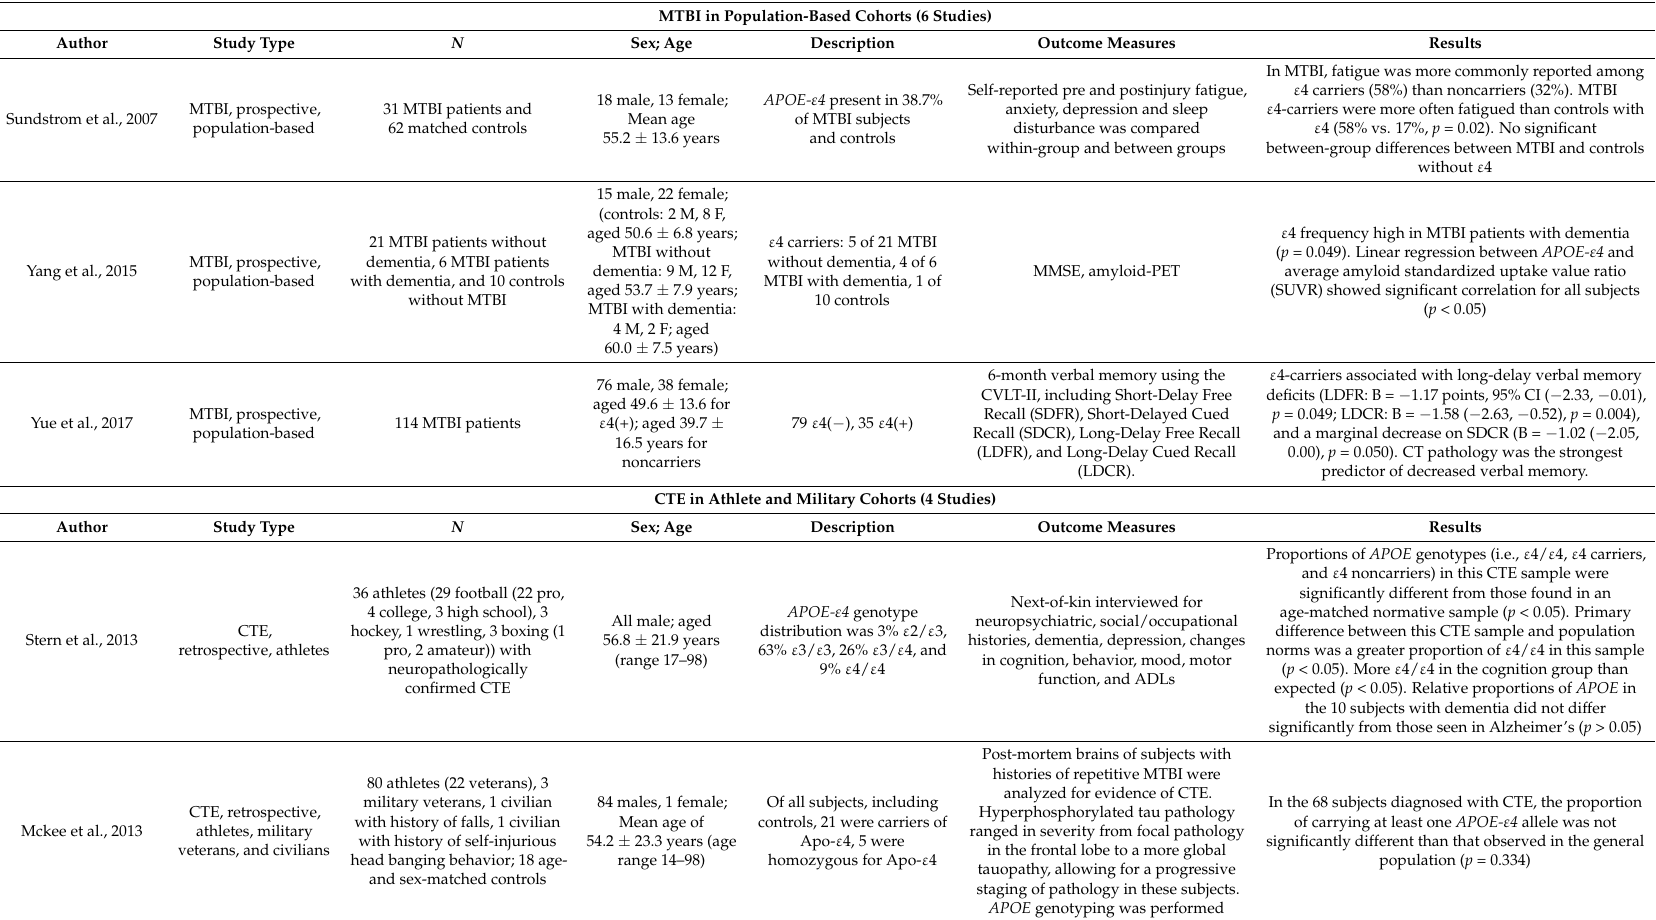
Search Criteria [Title/Abstract/MeSH Terms]: (Chronic Traumatic Encephalopathy or Mild Traumatic Brain Injury or Concussion) and Apolipoprotein